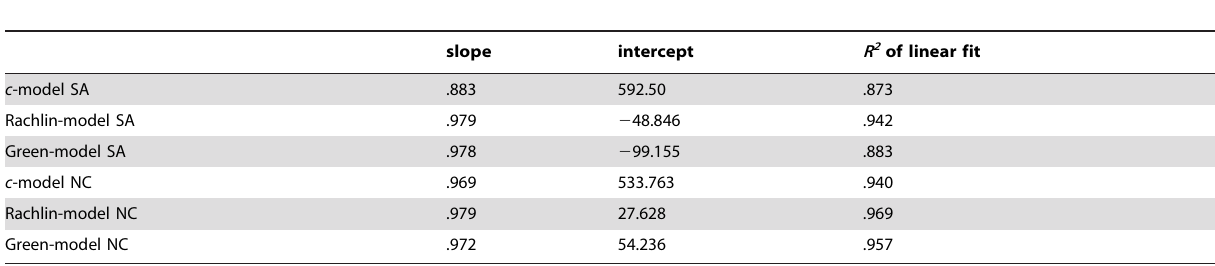
Table 5. Linear Regression of Predictive Validity of Models in SA and NC.